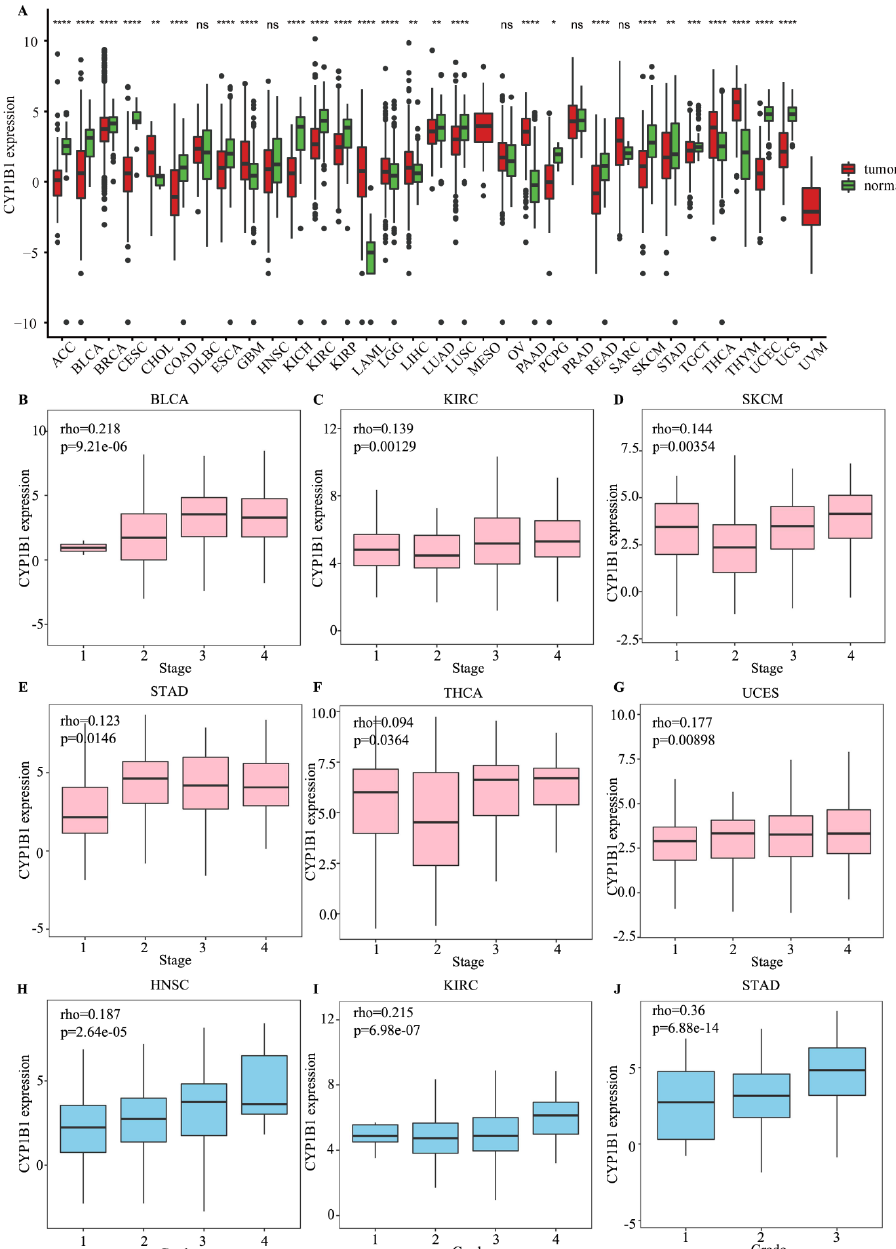
Figure 1. CYP1B1 expression, stage and grade in cancer. ( A ) CYP1B1 expression between tumor and normal samples in cancer. ( B – G ) The positive correlation between CYP1B1 expression and clinical stage in in BLCA ( B ), KIRC ( C ), SKCM ( D ), STAD ( E ), THCA, ( F ) and UCEC ( G ). ( H – J ) The positive correlation between CYP1B1 expression and tumor grade in HNSC ( H ), KIRC ( I ), and STAD ( J ). * means p <0.05 ; ** means p <0.01 ; *** means p <0.001 ; **** means p <0.0001 ; ns means no significance.